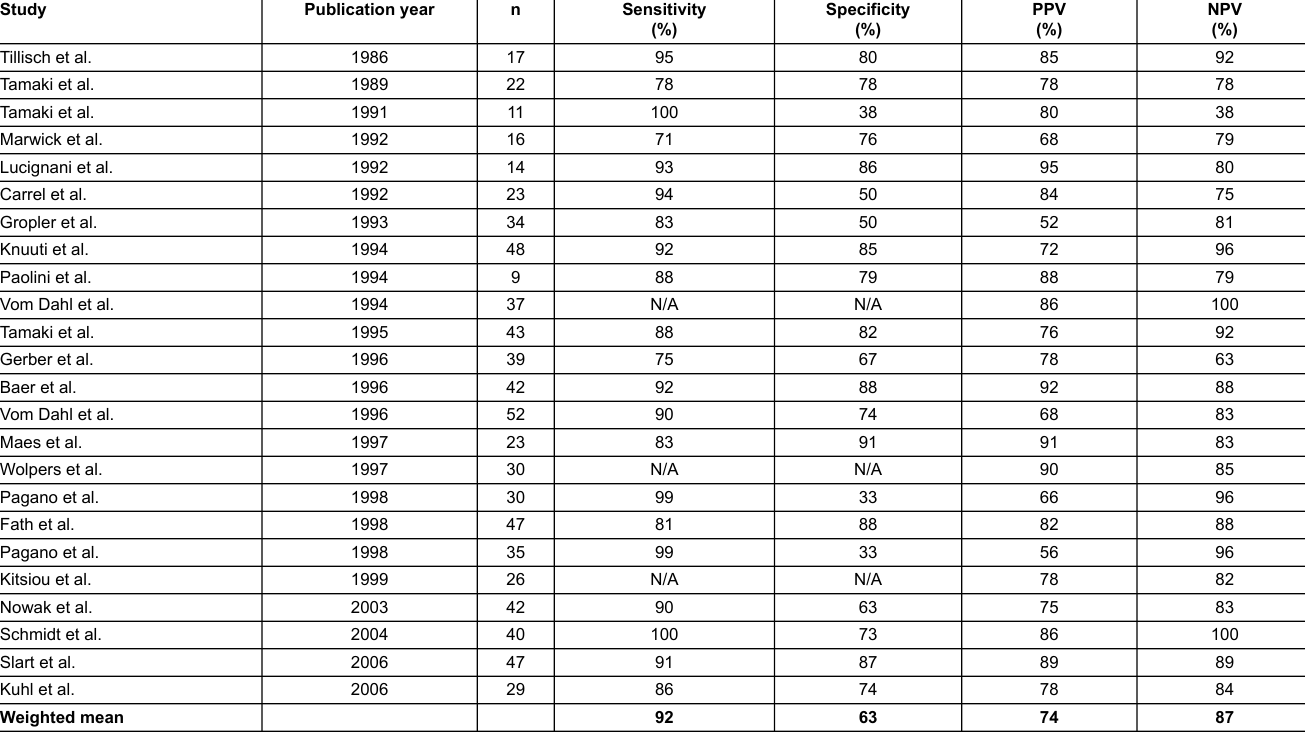
Table1: Sensitivity, specificity, positive- and negative-predictive values (PPV, NPV) of 18 F-FDG PET/CT to predict improvement of regional function after revascularisation (756 patients, 24 studies). Modified from Schinkel et al.